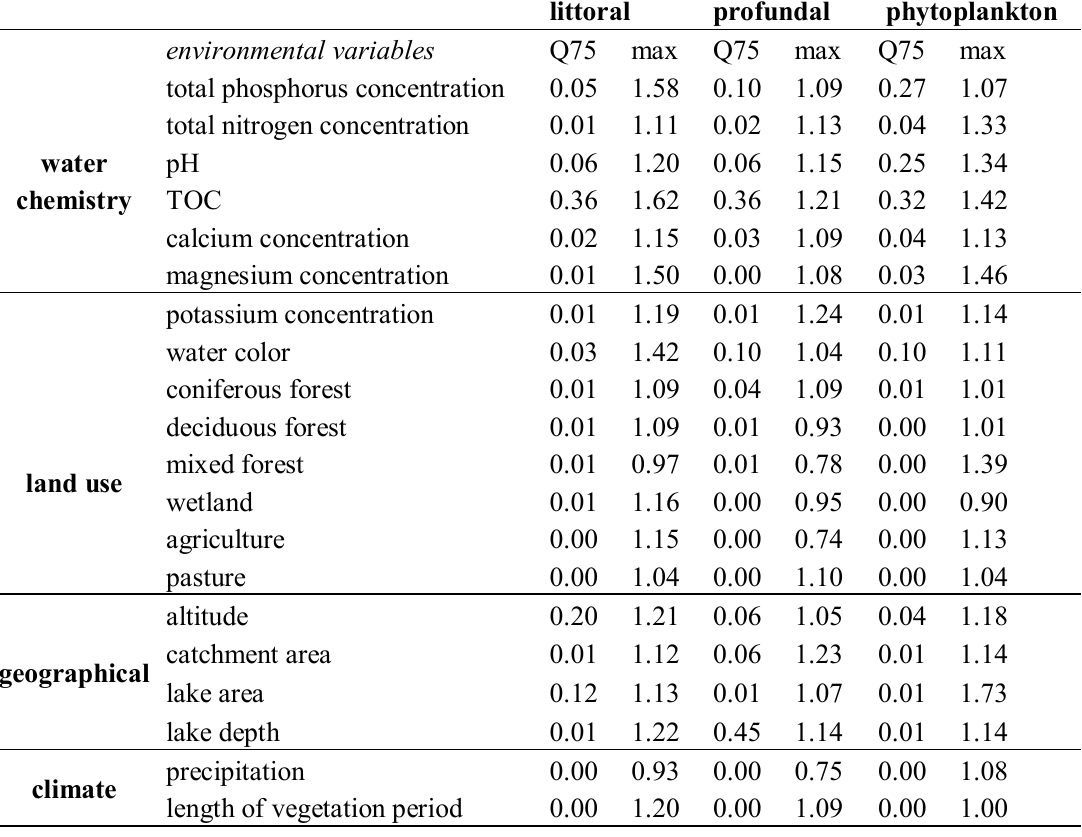
Table 5. Variable importance: 75th percentile (Q75) and maximum predictor variable influence (variable importance) for the prediction of littoral and profundal invertebrates and phytoplankton distribution. N per variable = number of species × 6 modeling techniques, i.e. , littoral = 984, profundal = 264, phytoplankton = 774. The distribution of variable importance is skewed towards zero, and therefore the 75th percentile (Q75) and maximum are